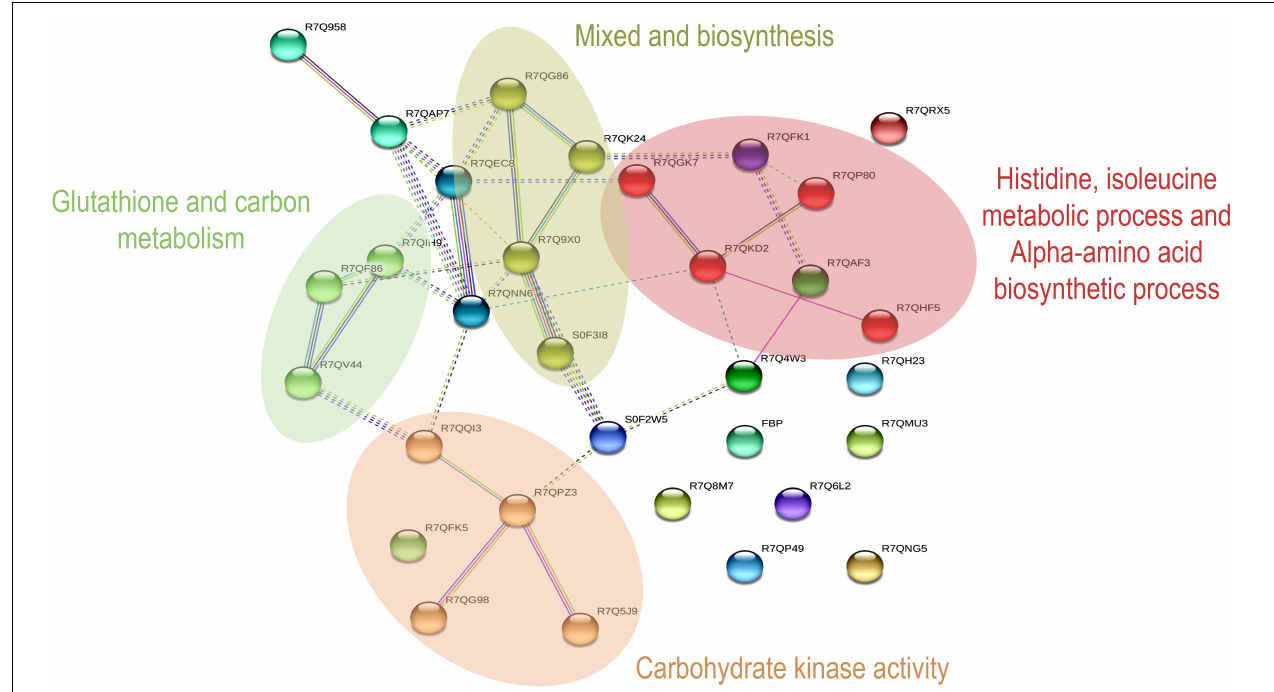
FIGURE 3 | Network analysis by KEGG pathway in Amino acid metabolism and Carbohydrate